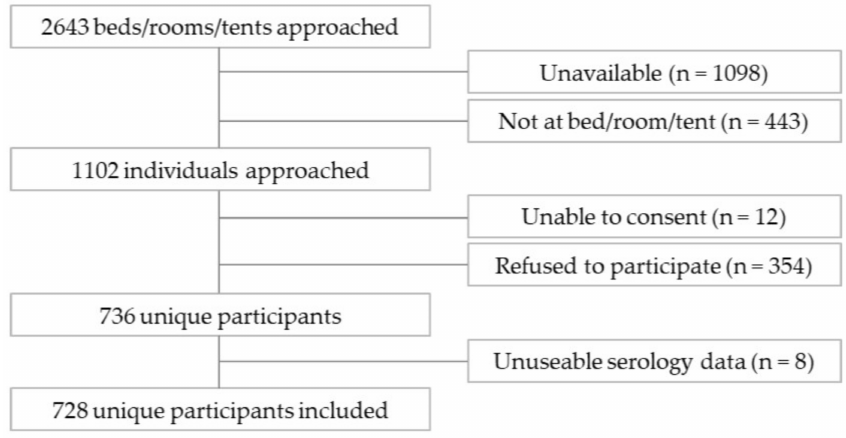
Figure 1. Ku-gaa-gii pimitizi-win recruitment and reasons for